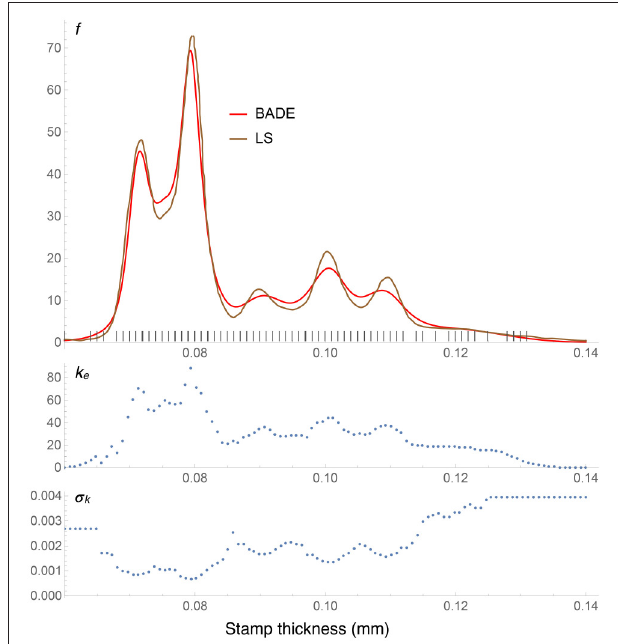
FIGURE 8 | Density estimates for the Hidalgo stamp data set, comparing our method (BADE) with LS (Brewer, 2000). The second and third rows show, respectively, the optimal effective number of nearest neighbors, and the standard deviation of the set of the k nearest neighbors, at each point of a regular grid of size 100. The marks on the x axis indicate the sample points; notice the equispacing due to rounding.